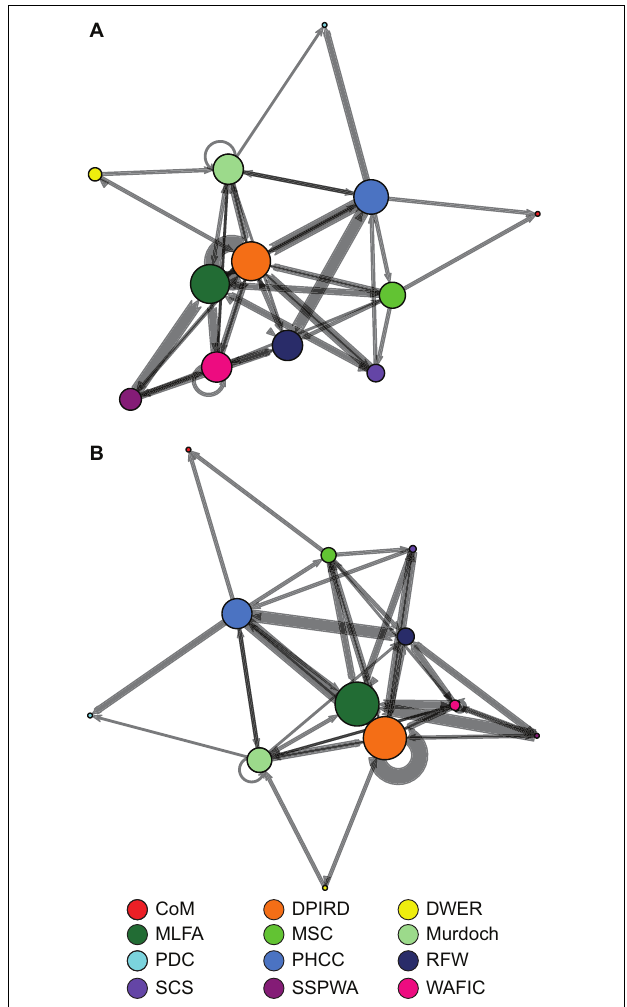
FIGURE 3 | Plots of the network of organizations represented in the closed population network with edge widths representing the frequency of relations between organizations and node sizes representing weighted degree centrality (A) and betweenness centrality (B) for